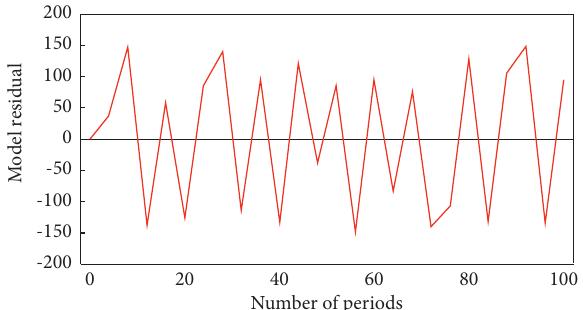
Figure 5: Dynamic variation of model residuals with different